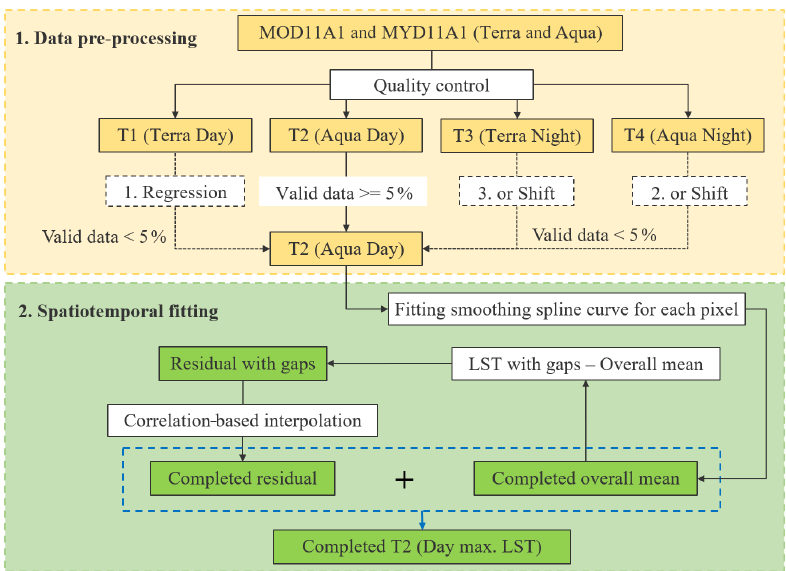
Figure 2. An overview of the spatiotemporal gap-filling framework (taking T2 as an